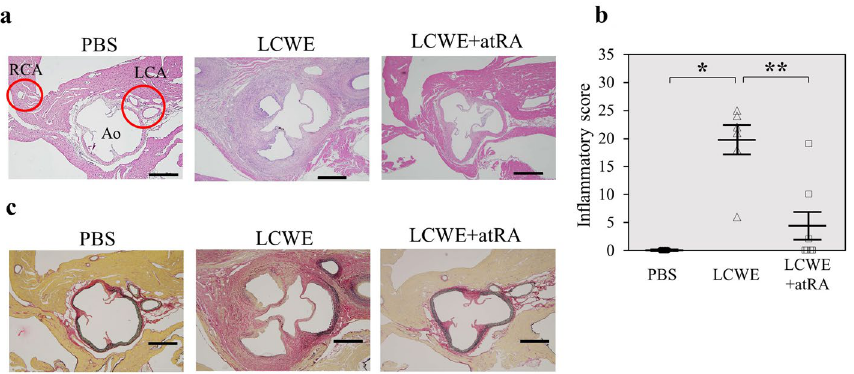
Figure 2. Effect of atRA on LCWE-induced vasculitis. Effect of atRA on LCWE-induced vasculitis. Mice were injected intraperitoneally with PBS (PBS, n = 5) or LCWE (n = 13). Two weeks later, LCWE-injected mice were further divided into two groups: no treatment (LCWE, n = 6) and atRA (LCWE + atRA, n = 7). All mice were sacrificed 16 weeks after LCWE or PBS injection. Representative photographs showing the cross-section of an aortic lesion containing the bilateral coronary arteries stained with H&E (a) and EVG (c) . RCA, right coronary artery; LCA, left coronary artery; Ao, aorta. Scale bar = 500 μm . (b) Semiquantitative evaluation of the CA inflammatory score in mice with PBS (n = 5) , LCWE (n = 6) and LCWE + atRA (n = 7). The values are expressed as the mean ± SD. *p < 0.05, **p < 0.0001. All the data were generated from 1 experiment at the same timeframe.